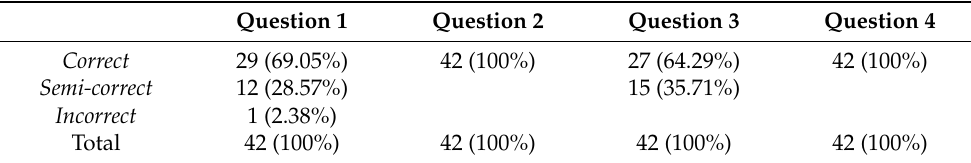
Table 5. Frequency and percentage of responses in the Zika virus